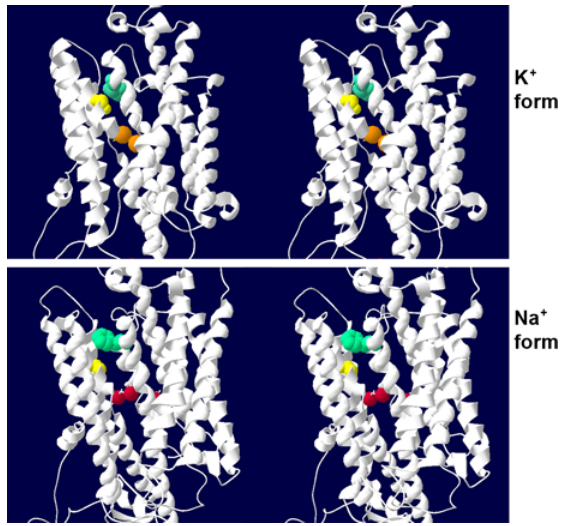
drift separately until a central image fuses. On the top, the transmembrane domain of Na,K-ATPase is shown from a crystal structure in the E2 (K + -bound) conformation. Gold spheres are K + ions in the ion binding pocket. The yellow space-fill residue is Gly316. Opposite it, the blue-green residue is Phe780, mutated to leucine in RDP. On the bottom, red spheres are Na + ions in the ion binding pocket of a crystal structure in the E1 (Na + bound) conformation. The rearrangement of transmembrane helices has separated Gly316 and Phe780